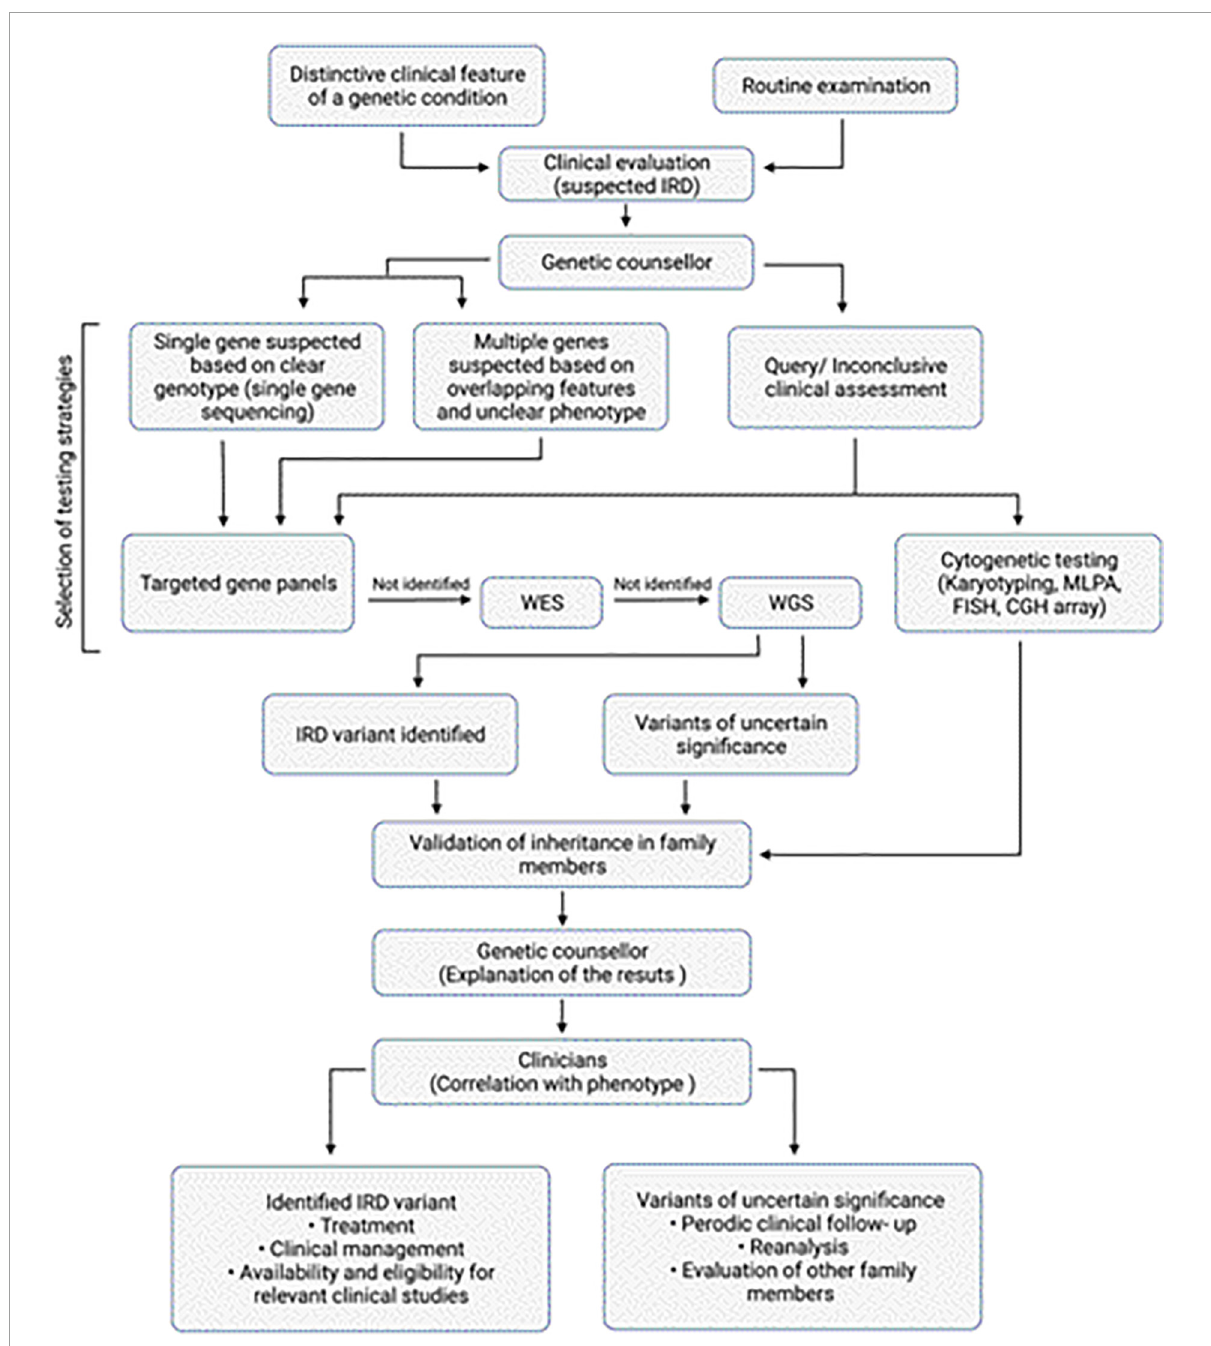
FIGURE1 Overview of diagnosis of IRDs. Algorithm for clinical and genetic assessment and diagnosis of IRDs. The work flow also depicts the various genetic testing approaches that can be selected based on the clinical assessment.